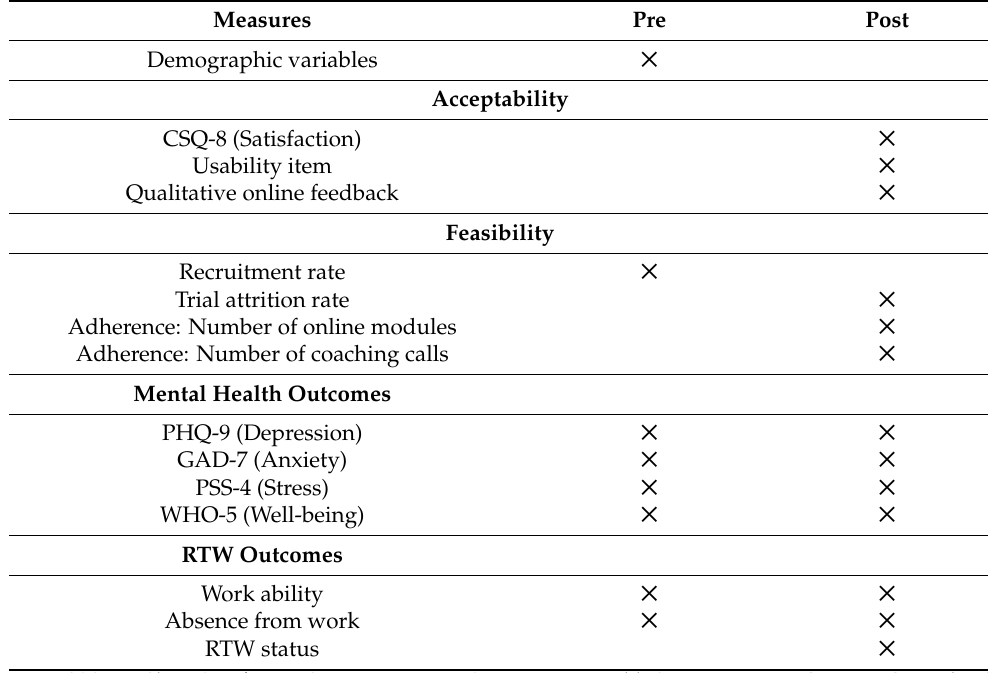
Table 2. Schedule of assessment